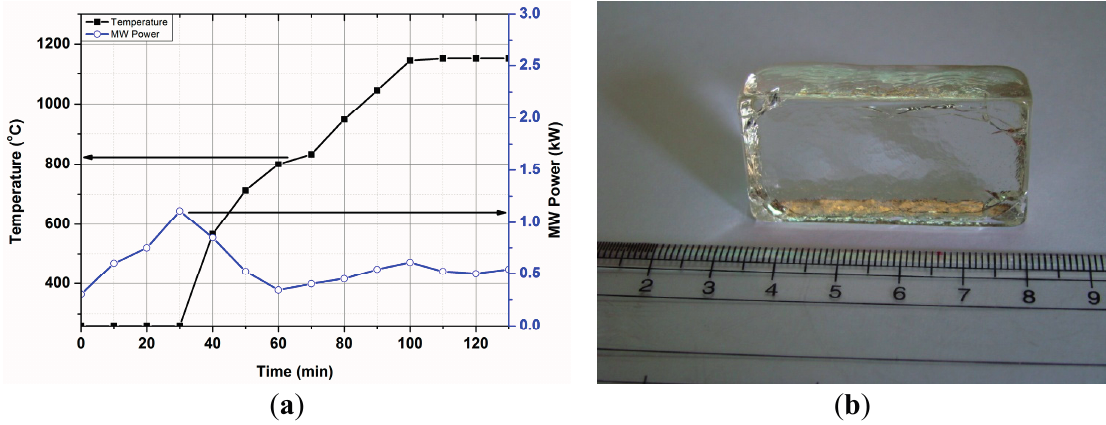
Figure 10. ( a ) T-P-t profile of BBS glass batch, (under direct microwave heating). ( b ) Photograph of annealed BBS glass.